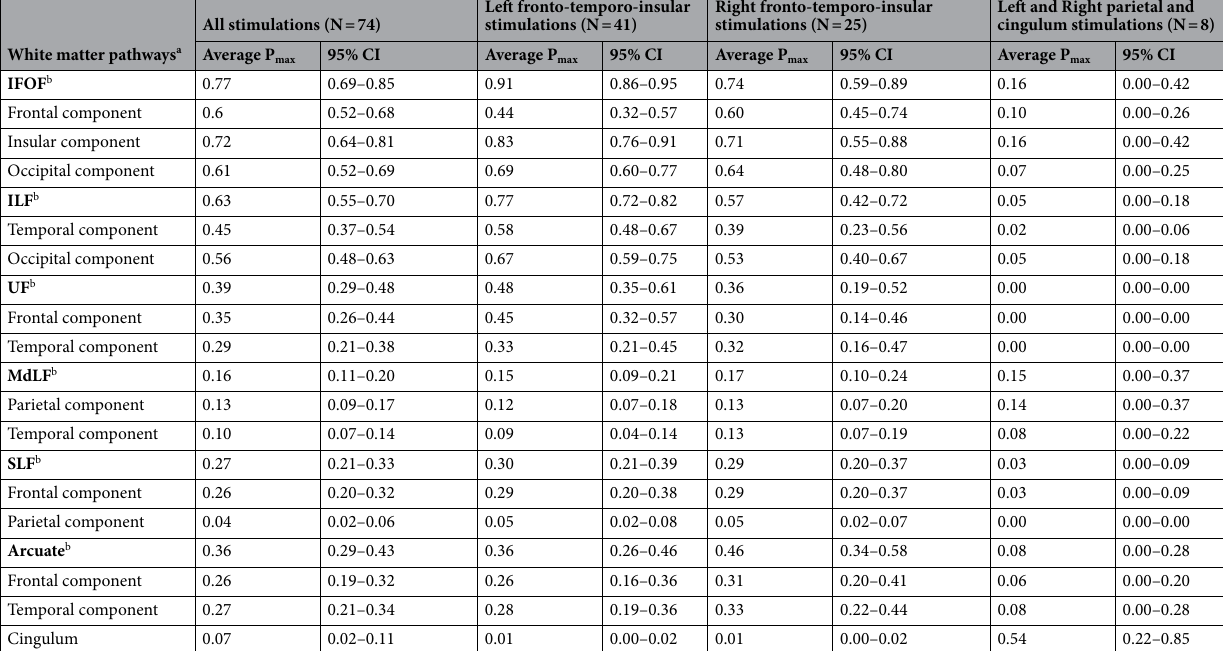
Table 2. Results of probabilistic disconnectome maps and subsequent disconnected white matter pathways in direct electrostimulations eliciting impairments of self-evaluative processing (N = 74). CI confidence interval, IFOF inferior fronto-occipital fasciculus, ILF inferior longitudinal fasciculus, MdLF middle longitudinal fasciculus, SLF superior longitudinal fasciculus, UF uncinate fasciculus. a Individual disconnectome maps were confronted to the Human Connectome Project 842 tractography database. Additional information concerning white matter tracts segmentation are provided in Supplemental data 1. b Average P max for each white matter tract corresponds to the average of each maximal probability of disconnection for this tract, including all its